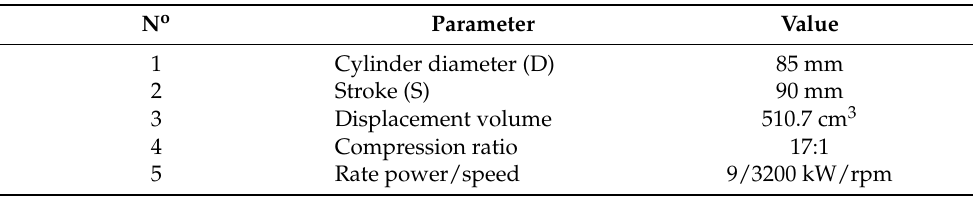
Table 5. Specifications of the engine.